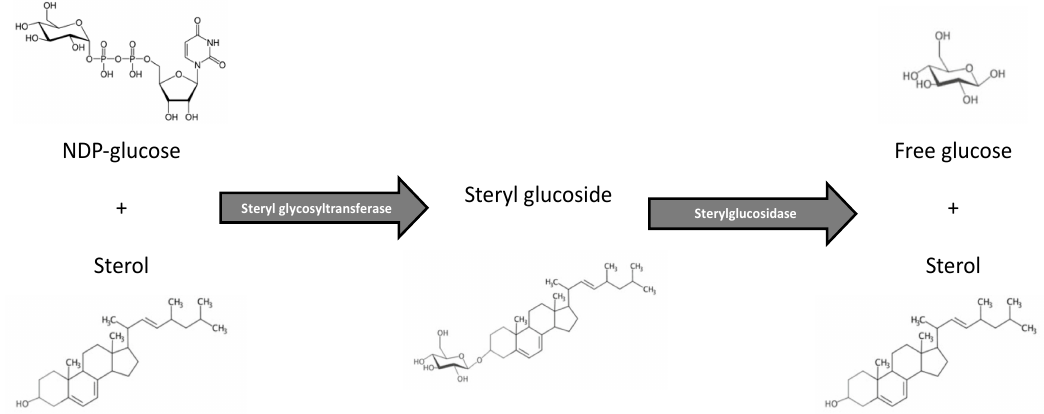
Figure 1. Steryl glucoside metabolism. Steryl glucosides are synthesized from a sugar moiety and free sterol via a steryl glycosyltransferase enzyme. Steryl glycosides are then hydrolyzed via a sterylglucosidase (also known as a steryl hydrolase) enzyme into its free sugar and free sterol subunits. This figure depicts the synthesis and catabolism of the steryl glucoside ergosteryl- β -3-glucoside in Cryptococcus neoformans using nucleotide diphosphate carrying glucose as the sugar source and free ergosterol as the sterol source. However, the number and type of sugar and the sterol species can differ by organism to make the steryl glycoside. Additionally, the anomeric bond can also be in the alpha or beta linked form. C. neoformans Δ sgl1 lacks the sterylglucosidase enzyme and therefore accumulates a large concentration of steryl glucosides.